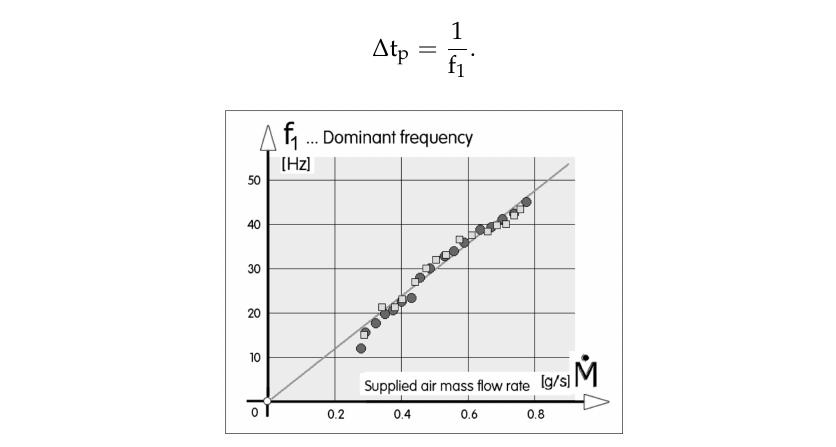
Figure 13. Result of measured fundamental oscillation frequency as a function of the supplied mass flow rate. Apart from the friction-dominated low-velocity lower end the dependence is well fitted by a linear